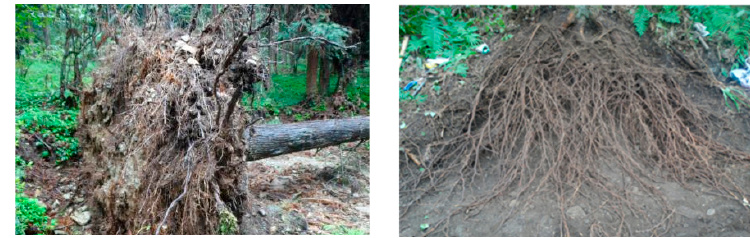
Figure 4. Root growth morphology of Chinese fir.